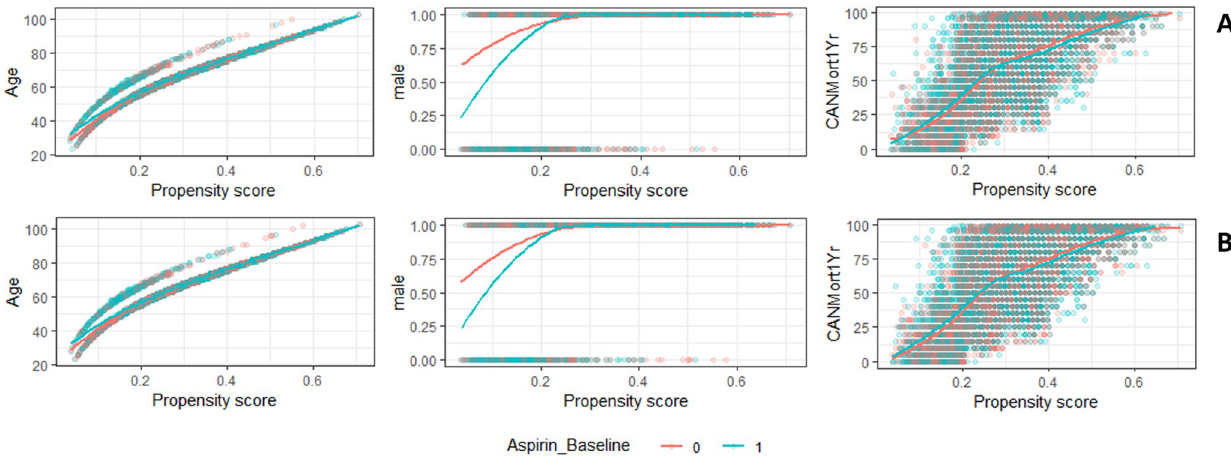
Fig 2. Scatter plots with fitted lines of the association between the propensity score and the matched covariates (age, gender and CAN 1-year mortality score). 30-day mortality assessment cohort (A) and the 14-day mortality assessment cohort (B).